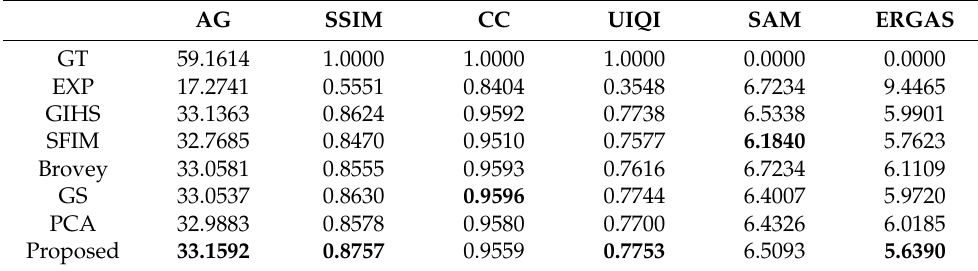
Table 2. Objective assessment indexes of the GE-1 image fusion